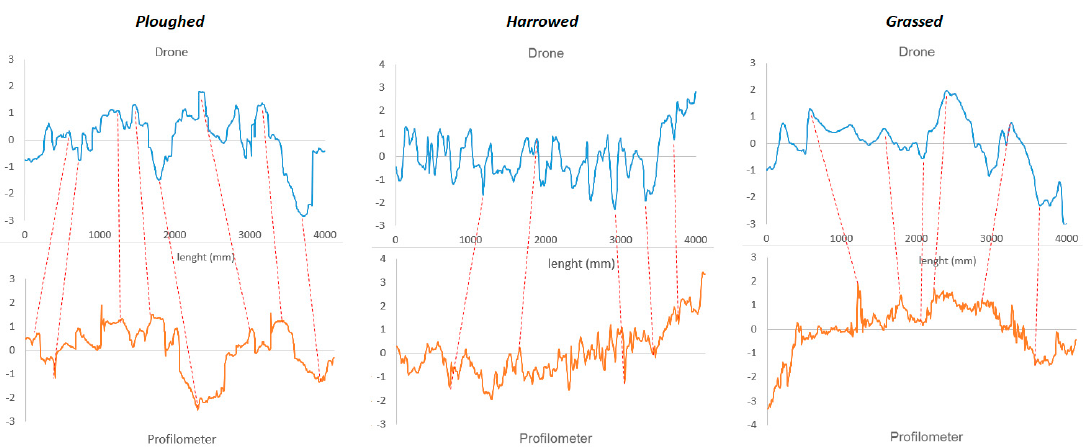
Figure 4. Profiles of the 3 types of soil (ploughed, harrowed and grassed) extracted with both light drone (blue line) and profilometer (orange line). y -axes are adimensional.